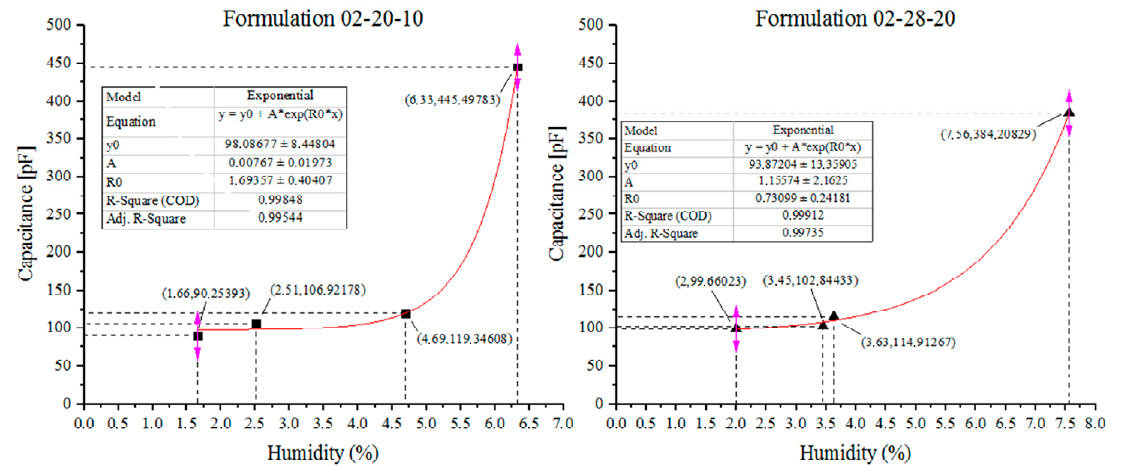
Figure 9. Sensor response to different moisture contents in the formulations 02-20-10 and 02-28-20.